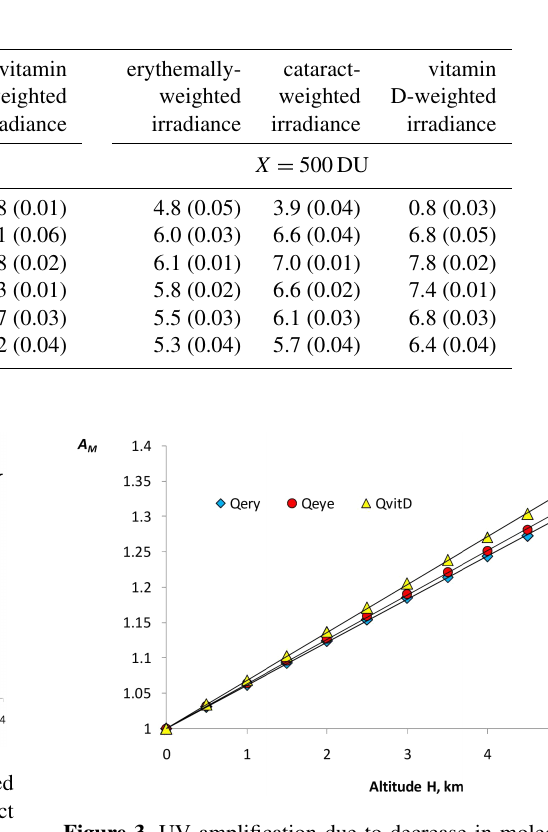
Figure 3. UV amplification due to decrease in molecular number density with the altitude H according to accurate model simula- tions: TUV, 8-stream DISORT TUV model. h = 50 ◦ . X =